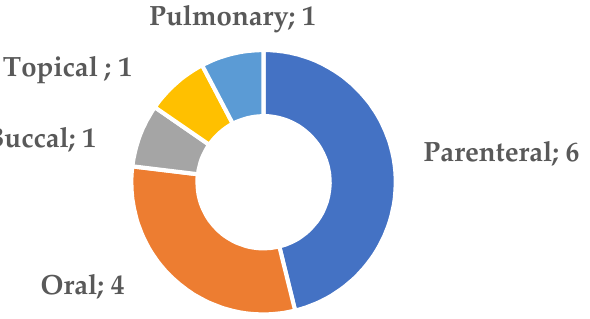
Oral; Figure 1. Numbers of papers published by administration route used (or Figure 1. Numbers of papers published by administration route used (or intended).